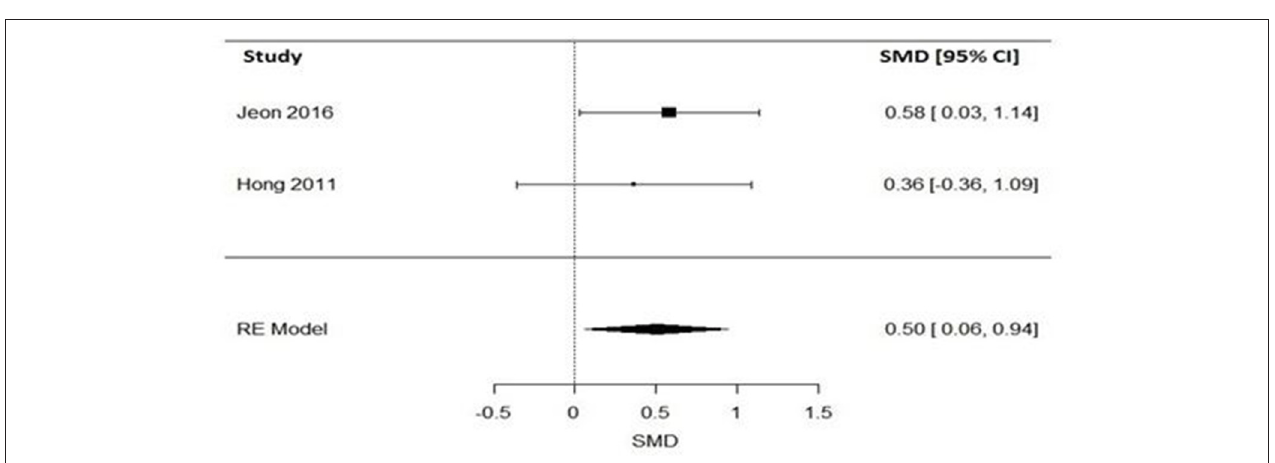
FIGURE 4 | Forest plot meta-analysis of two RCTs for the effect of varenicline compared to placebo on the expired carbon monoxide in schizophrenia patients. SMD, standard mean difference; CI, confidence interval; RE, random effect.